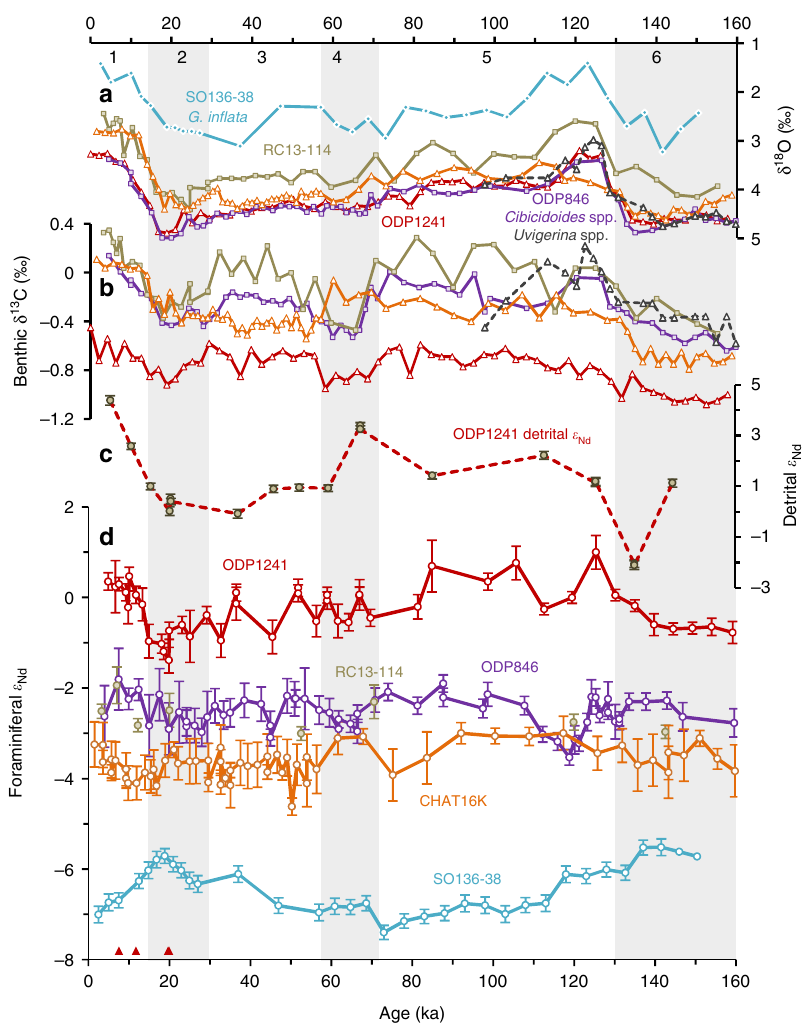
Fig. 3 Records spanning the last glacial cycle (0 – 160 ka). a Benthic δ 18 O and b δ 13 C records of ODP1241 (red) 55 , ODP846 (purple squares for Cibicidoides spp. and grey triangles for Uvigerina spp.) 70 , RC13-114 (brown) 71 , CHAT16K (orange) 9 and SO136-38 (cyan) 51 . c Detrital ε Nd record of ODP1241. d Foraminiferal ε Nd records. The red triangles beside the bottom axis represent 4 calibrated AMS 14 C dates of planktonic foraminiferal species N. dutertrei (Supplementary Table 9). Numbers on the top show MIS stages, and the grey bars highlight the glacial stages (MIS 2, 4, and 6). Error bars show the 2 σ external error of the ε Nd